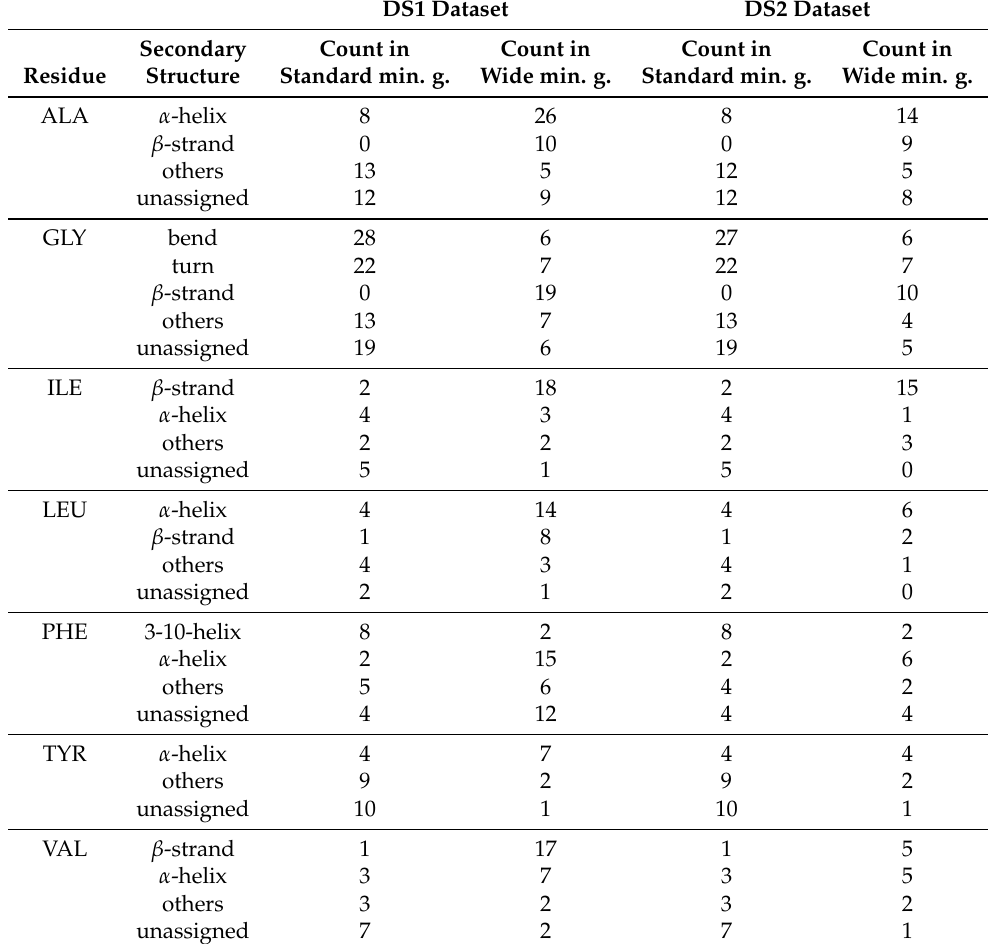
Table 2. Secondary structure preferences of hydrophobic amino acids indicated by numbers of